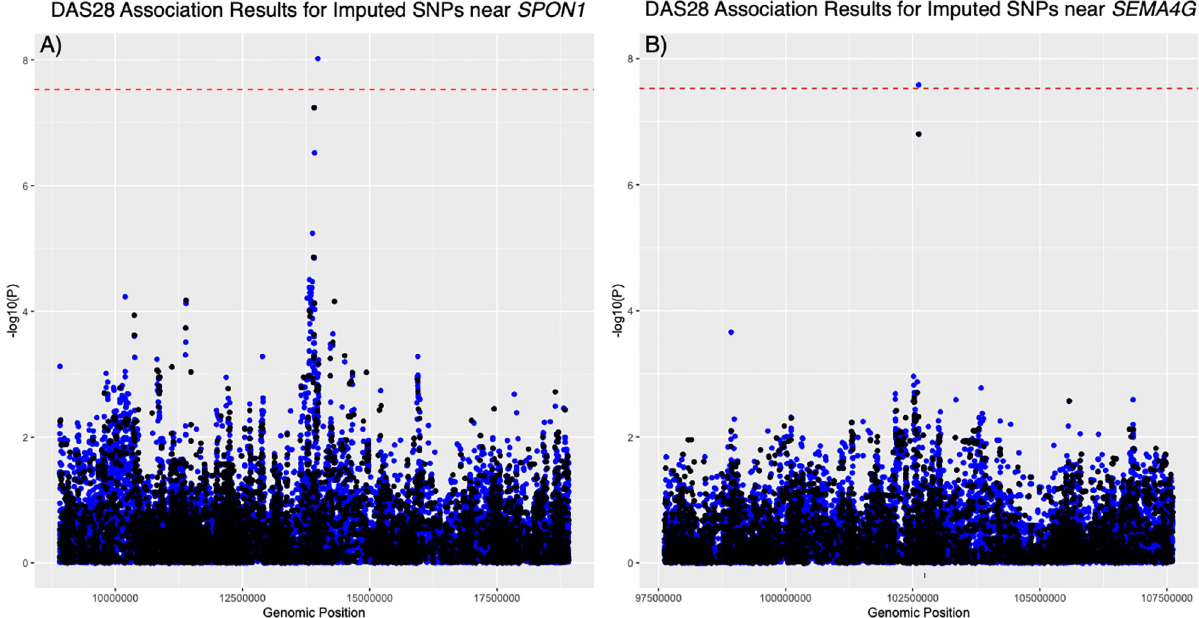
Fig 3. Fine mapping of regions with suggestive associations with DAS28 (week 12). (A) Manhattan plot of significance scores from linear regression analysis of DAS28 for common SNPs in a 10Mb window around the SPON1 locus. (B) Manhattan plot of significance scores from linear regression analysis of DAS28 for common SNPs in a 10Mb window around the SEMA4G locus. SNPs genotyped on the Omni2.5M array are shown in black while imputed SNPs appear in blue. The dotted red line indicates the original Bonferroni threshold for significance.